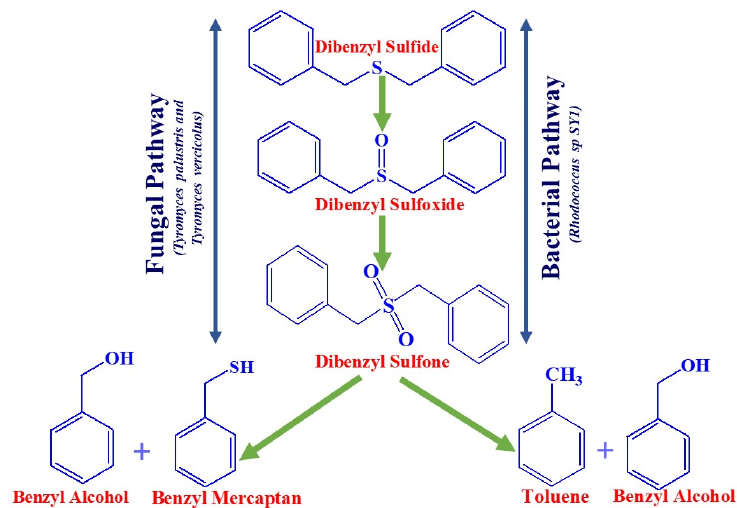
Figure 4. Pathways for the desulfurization of